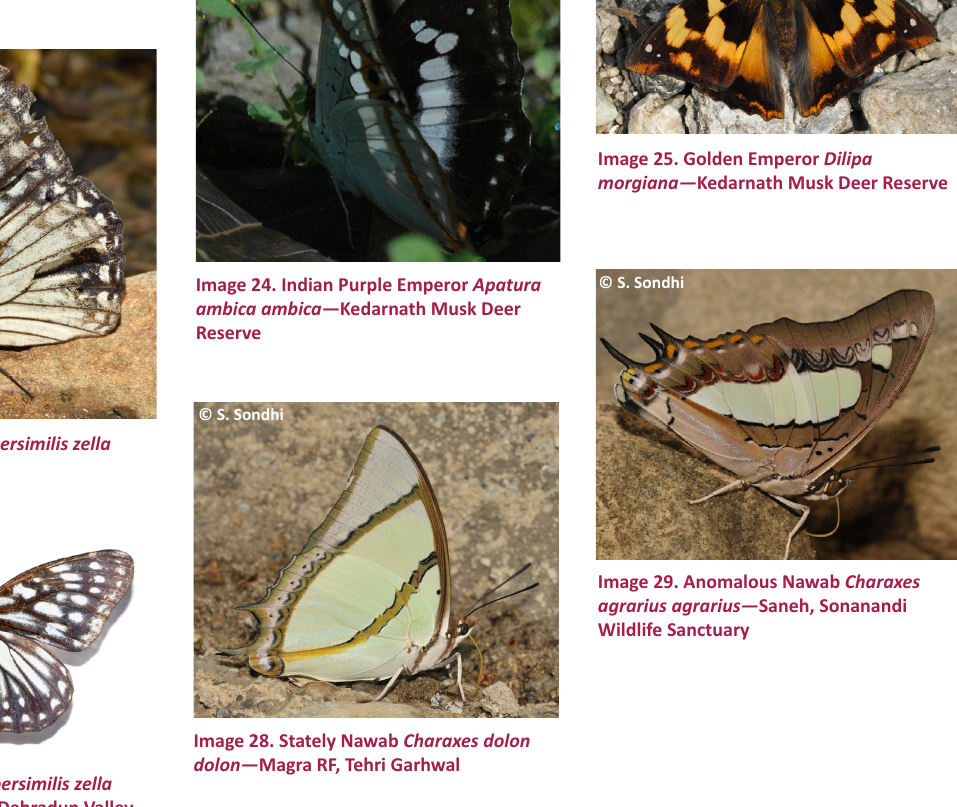
Image 23. Jewel Four-ring Ypthima avanta— Chakarata Hills